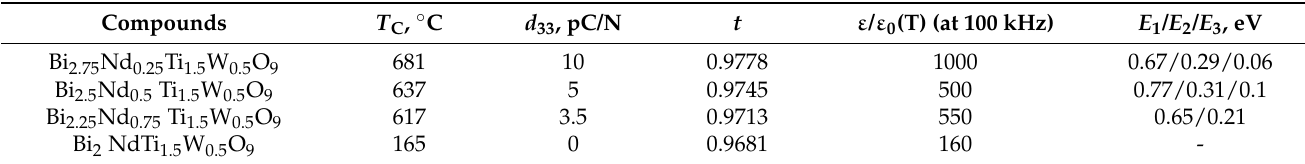
Table 2. Dielectric characteristics of Bi 3 − x Nd x Ti 1.5 W 0.5 O 9 (x = 0.25, 0.5, 0.75, 1.0): Curie temperature